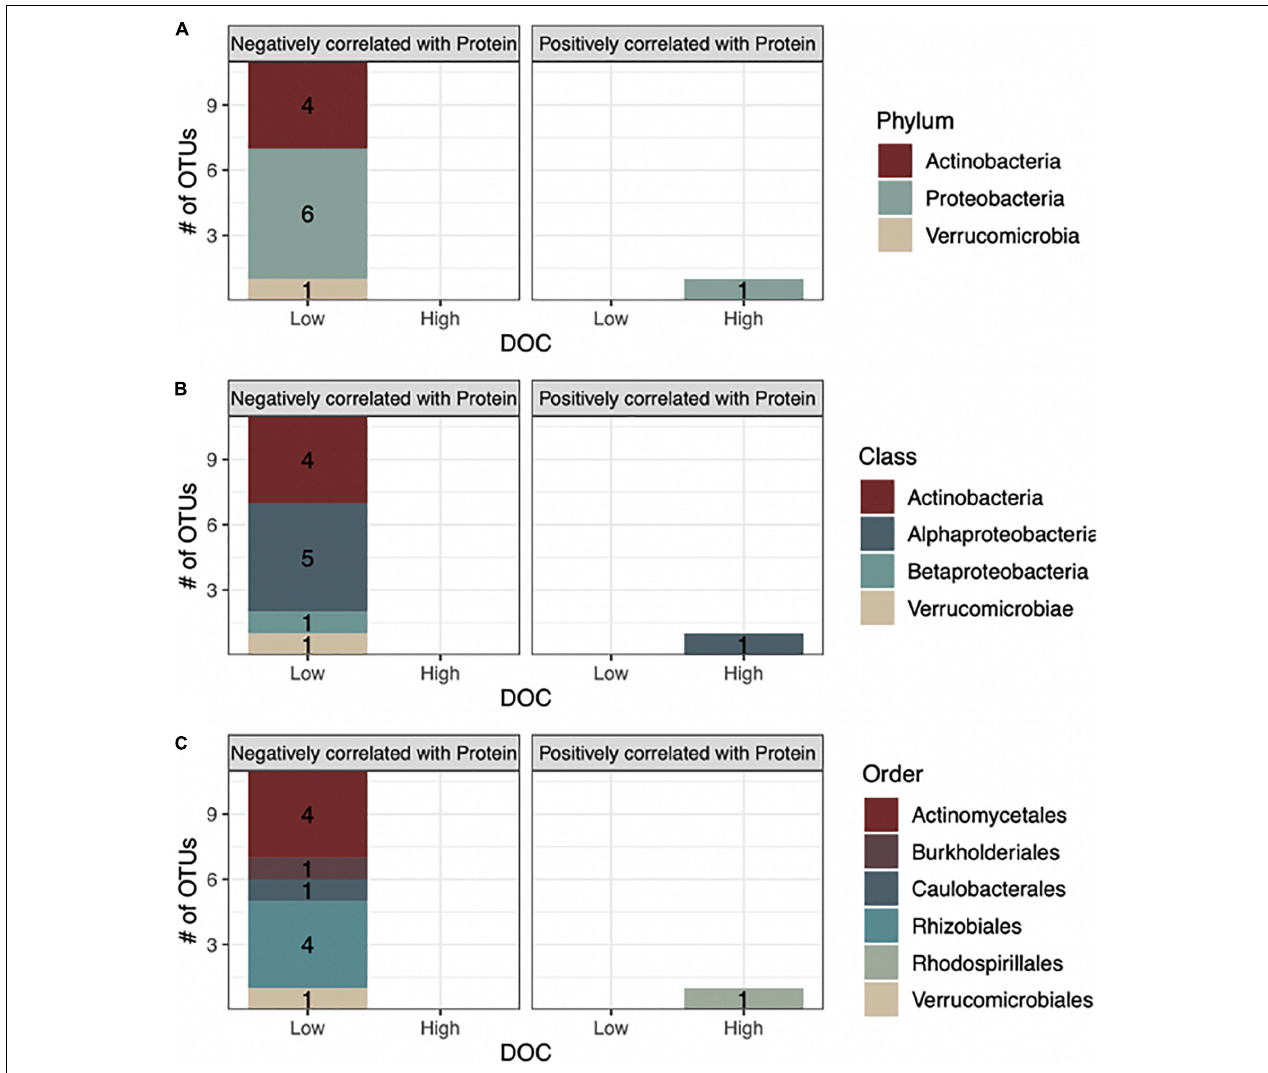
FIGURE 4 | The majority of bacterial OTUs that are associated with high or low DOC are negatively correlated with protein. Stacked barplots indicate the number of bacterial OTUs that correlated negatively (left barplots) or positively with protein (right barplots) and their association with either high or low DOC based on indicator species analysis is shown at (A) phyla, (B) class, and (C) order